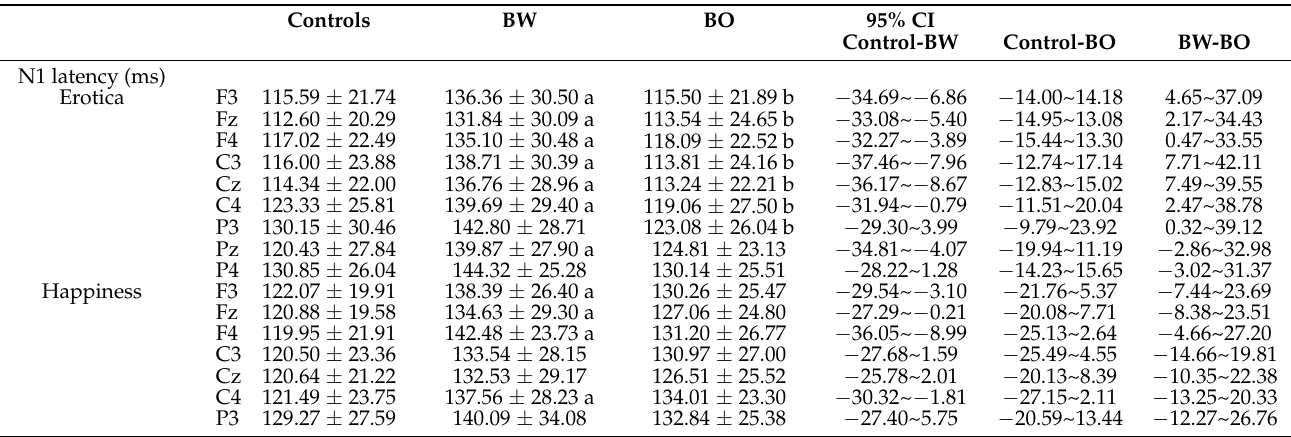
Table 2. N1 latencies (mean ± S.D.) under Erotica and Happiness and P3b amplitudes under Fear and Sadness in the healthy volunteers (Controls, n = 54), bipolar I disorder patients with (BW, n = 27) and without (BO, n = 26)